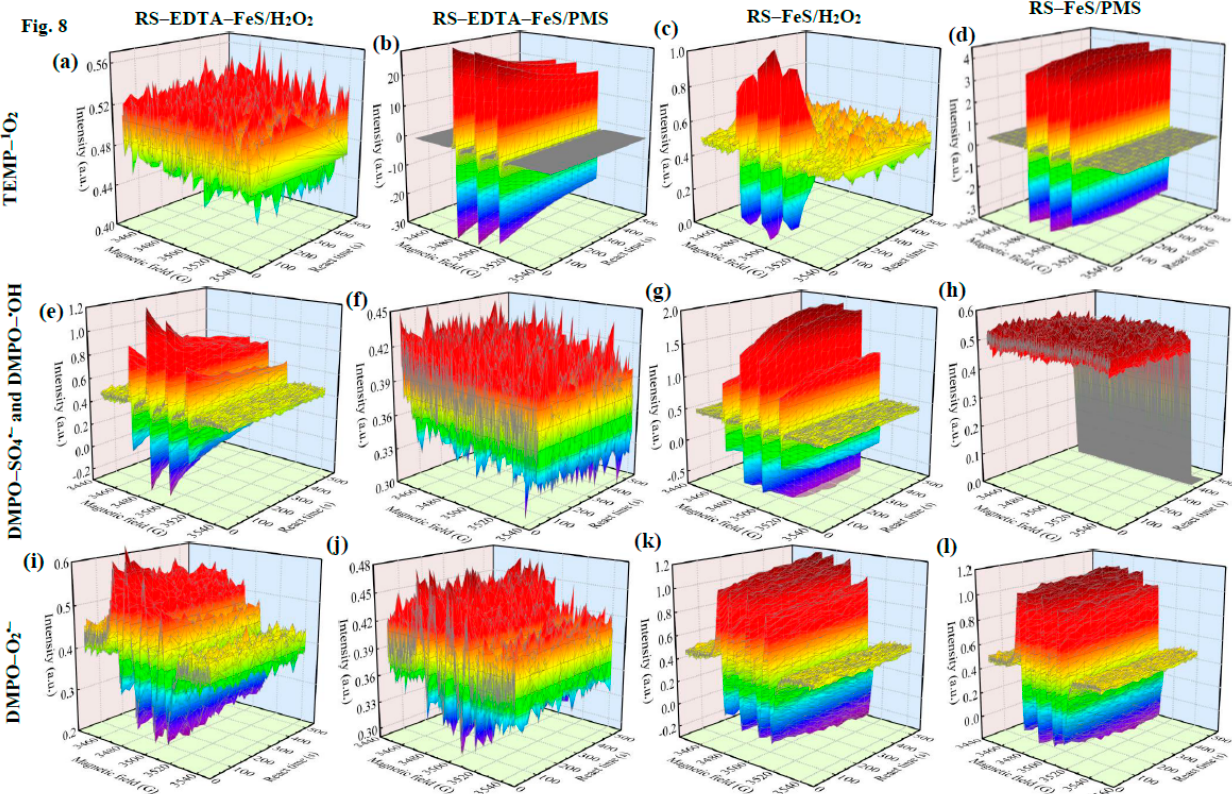
Figure 8. EPR spectrum on radicals in RS–FeS/PMS, RS–EDTA–FeS/PMS, RS–FeS/H 2 O 2 , and RS–